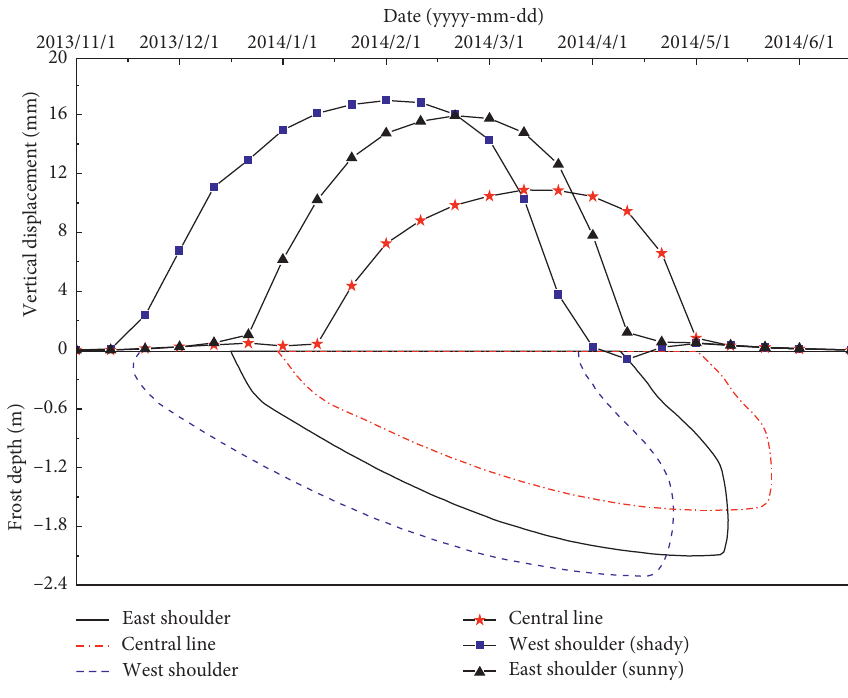
Figure 8: Time history curves of vertical displacement and frost